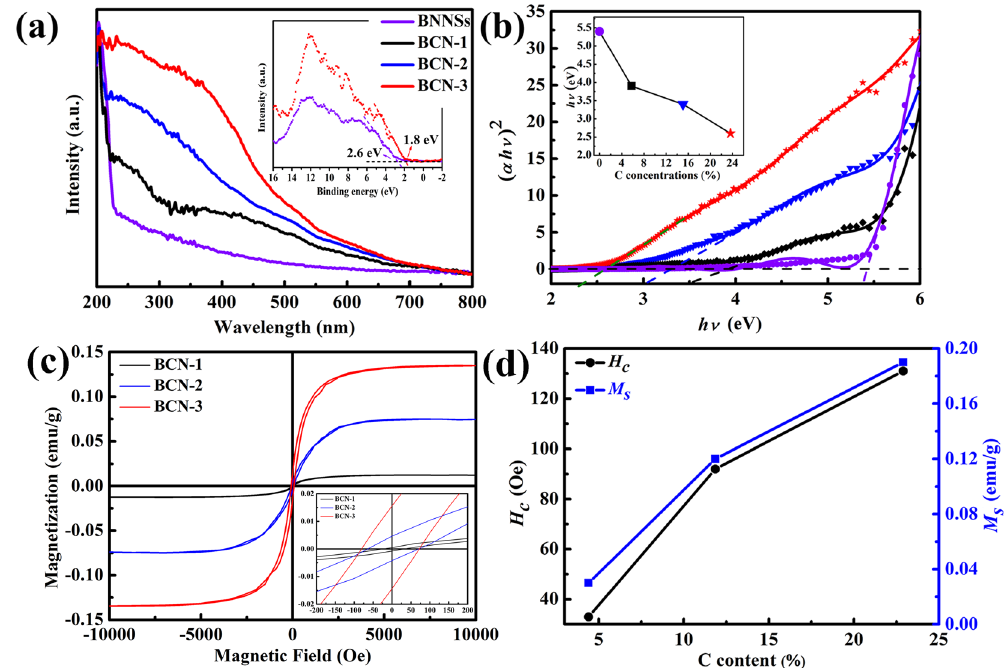
Figure 3. Absorption and magnetic properties of the as-prepared BCN nanosheets. ( a ) UV-vis diffuse reflectance spectra (DRS) results. Inset is the valence-band XPS spectra comparison of the BNNSs and BCN nanosheets. ( b ) Tauc plot of the as-prepared BCN nanosheets with different C concentrations. The inset shows the band gap variation of BNNSs and BCN nanosheets from the Tauc plot. ( c ) Magnetization vs. magnetic field ( M-H ) curves of different C concentration nanosheets measured at room temperature. The curves show nonzero magnetization at room temperature. ( d ) Relationship between saturation magnetization and coercive fields with C